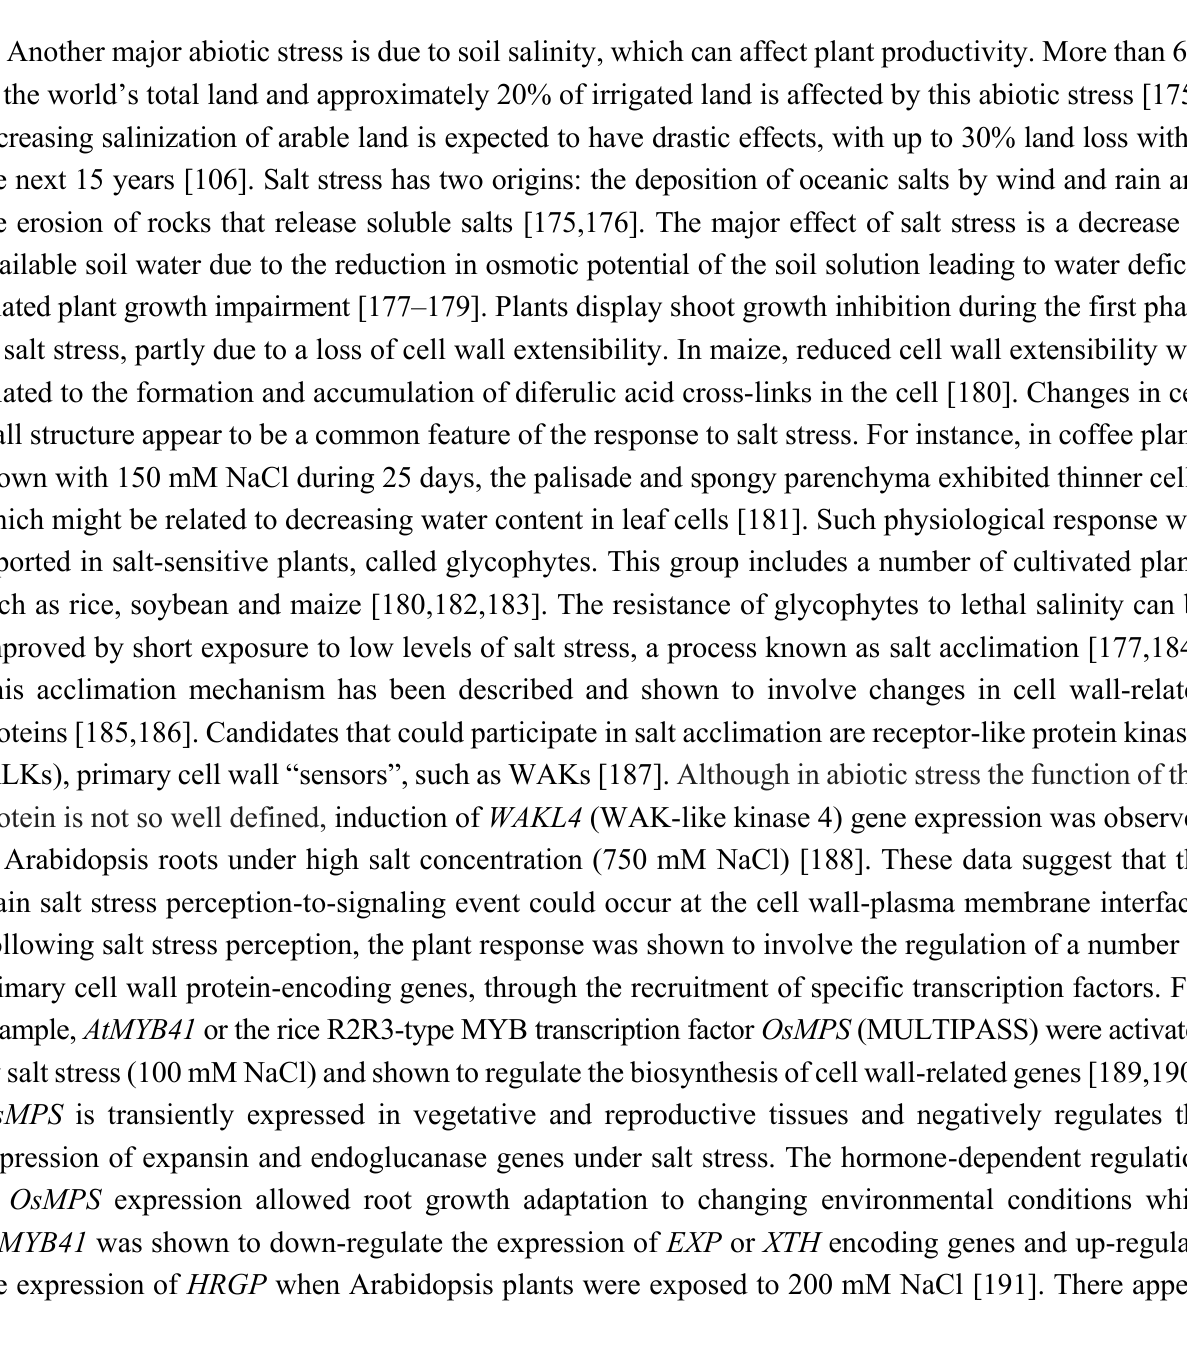
Figure 4. Overview of the plant cell wall response to cold. The schematic presentation is deduced from the results of different studies reported in the review. Arrow (  ) means increased abundance and arrow (  ) means decreased abundance of the molecules. Star (  ) means contrasting data on the gene/protein or the molecule studied according to the literature cited in the review. Cell wall (CW); xyloglucan endo-β-transglucosylases/hydrolases (XET/XTH); pectin methylesterase (PME); UDP- D -xylose 4-epimerase (MUR4); phenylalanine